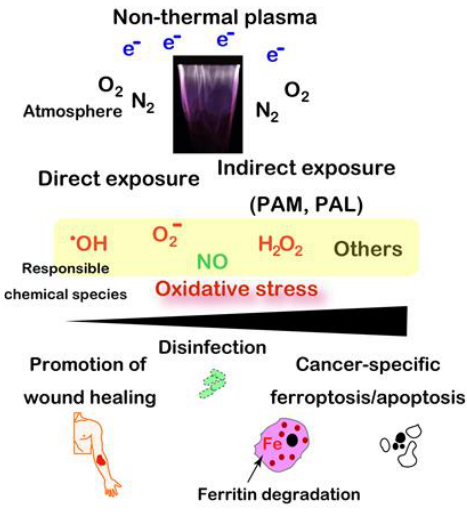
Figure 6. Wide applicability of non-thermal plasma to biomedical field, including specific ferroptosis inducer for cancer cells. PAM, plasma-activated medium. PAL, plasma-activated Ringer’s lactate solution.